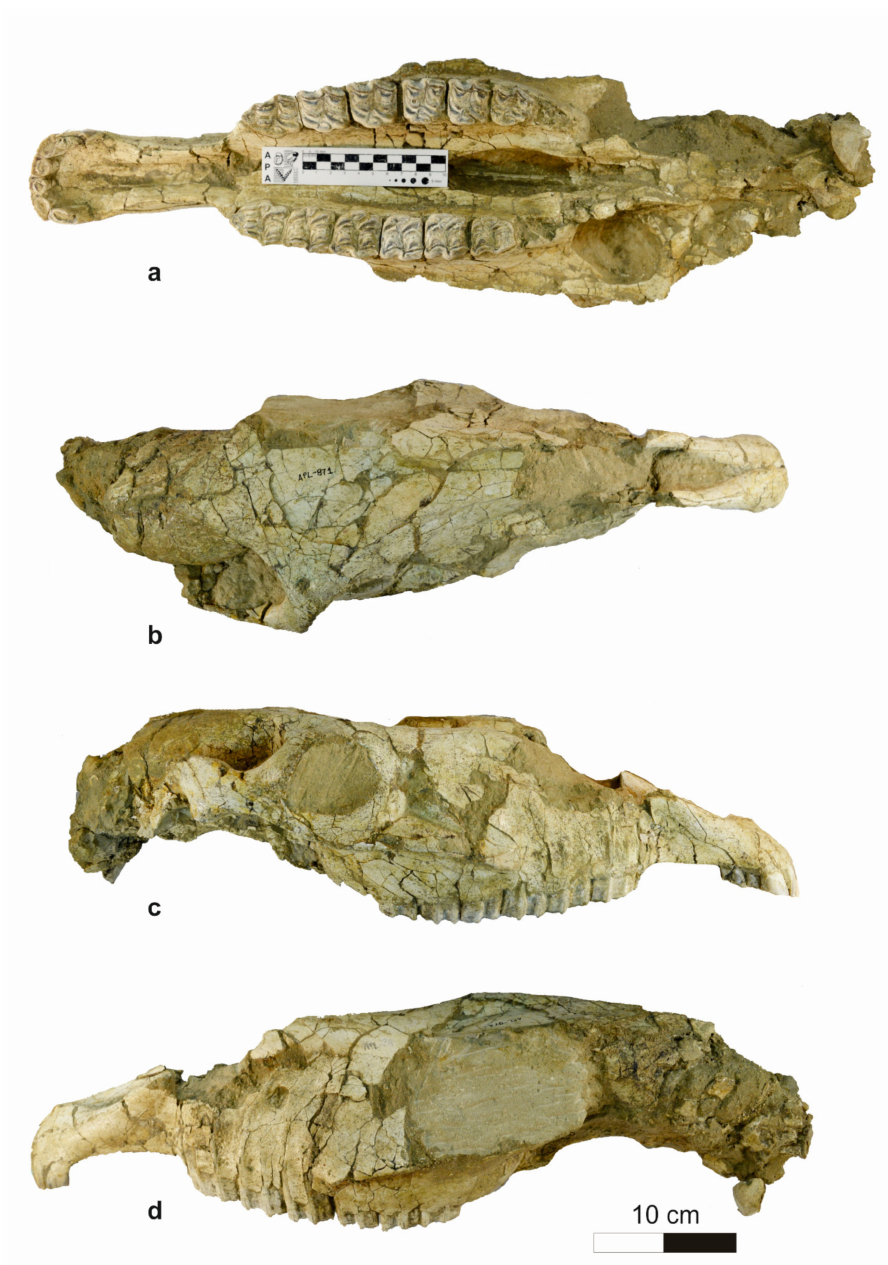
Figure 3. Equus apolloniensis , APL-871; ( a – d ) cranium, ( a ) ventral view, ( b ) dorsal view, ( c ) right lateral view, and ( d ) left lateral